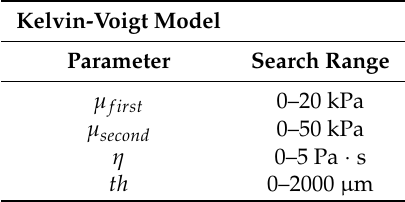
Table 7. The range of the parameters implemented for the FDTD model